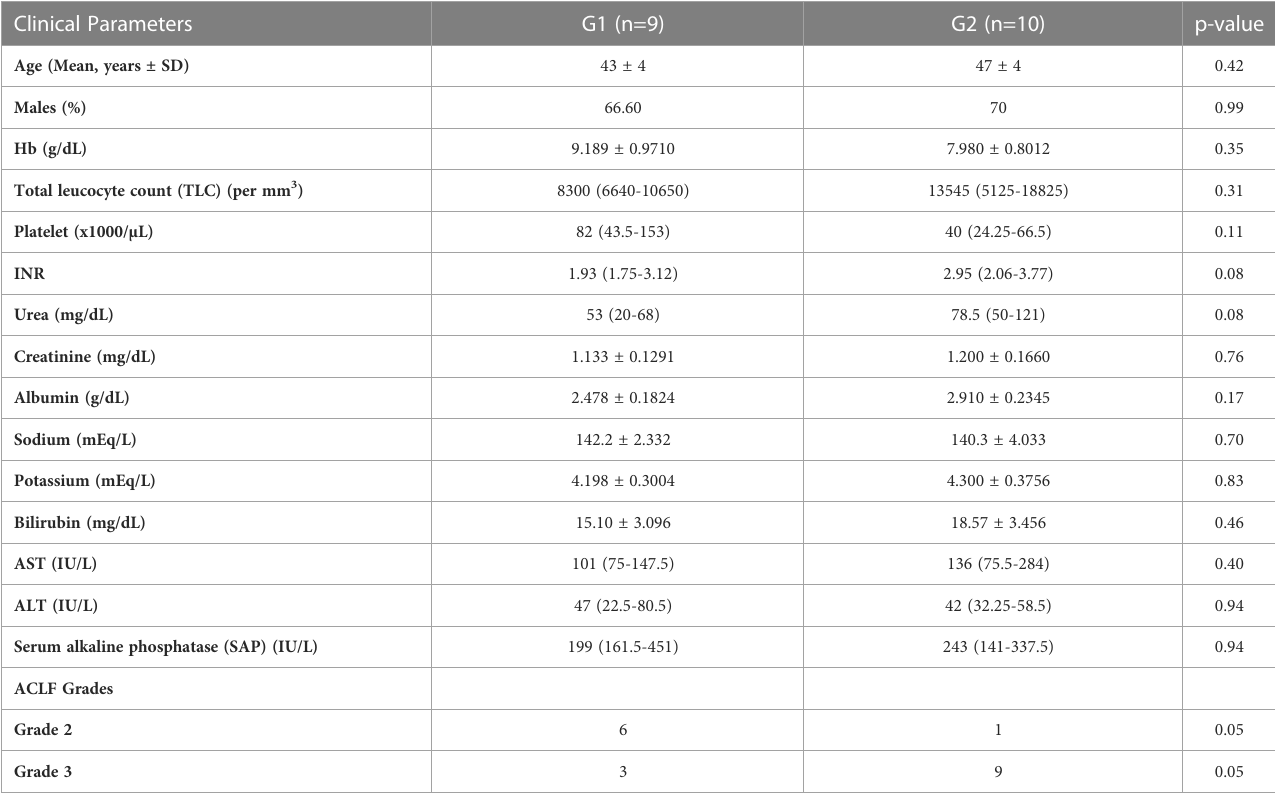
TABLE 2 Baseline characteristics of ACLF samples subjected to proteomic analysis. Clinical